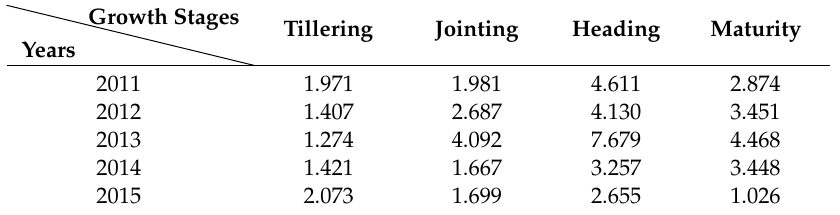
Table 3. The variance inflation factors (VIFs) of MODIS-GPPs at the key growth